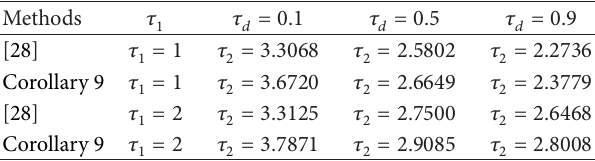
Table 2: Allowable upper bound 𝜏 2 for different 𝜏 𝑑